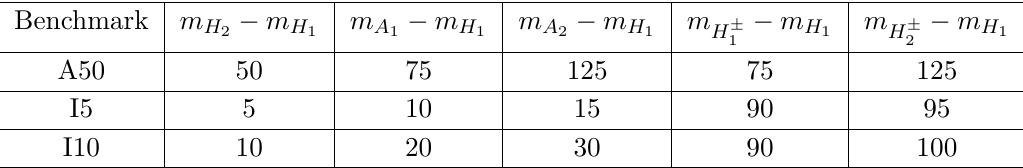
- H and H - A mass splittings, 12 leads to 1 2 1 1 ; 2